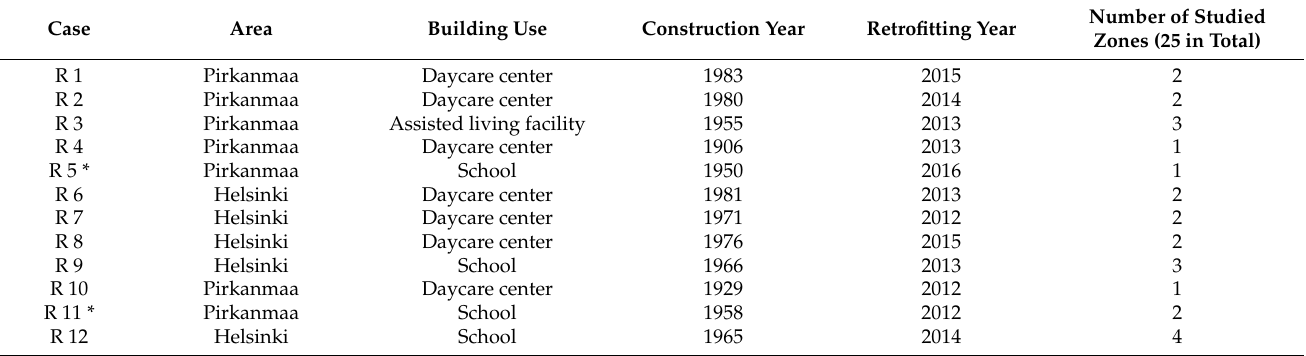
Table A2. The retrofitted case study buildings. The city of Helsinki is located in Southern Finland and the Pirkanmaa region in the southwest part of Finland. (*) Building has a new and retrofitted